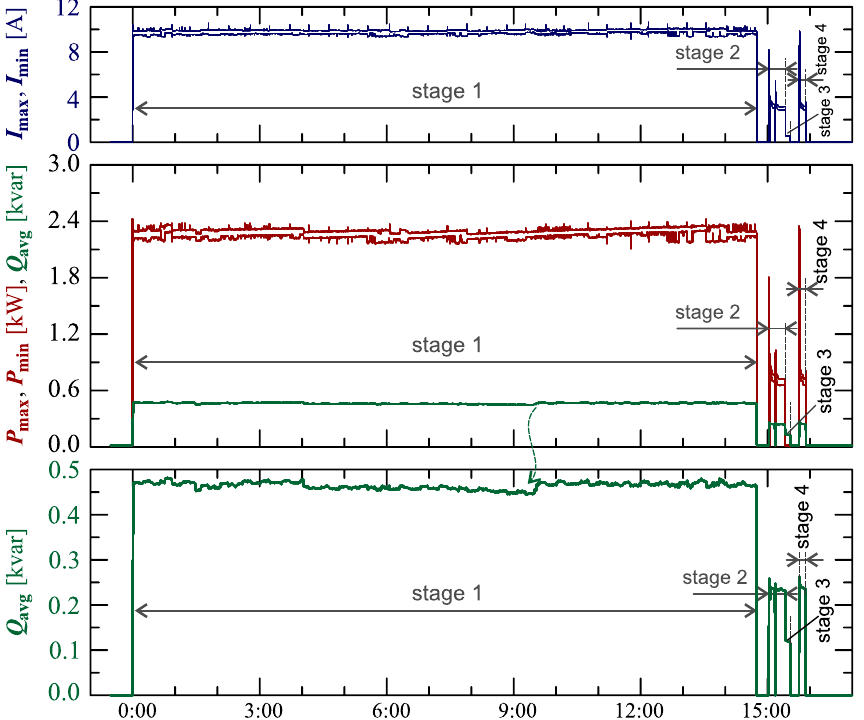
Figure 29. The characteristics of maximum P max = f ( t ) and minimum P min = f ( t ) values of active power and average values of reactive power Q agv = f ( t ) for Case IV.